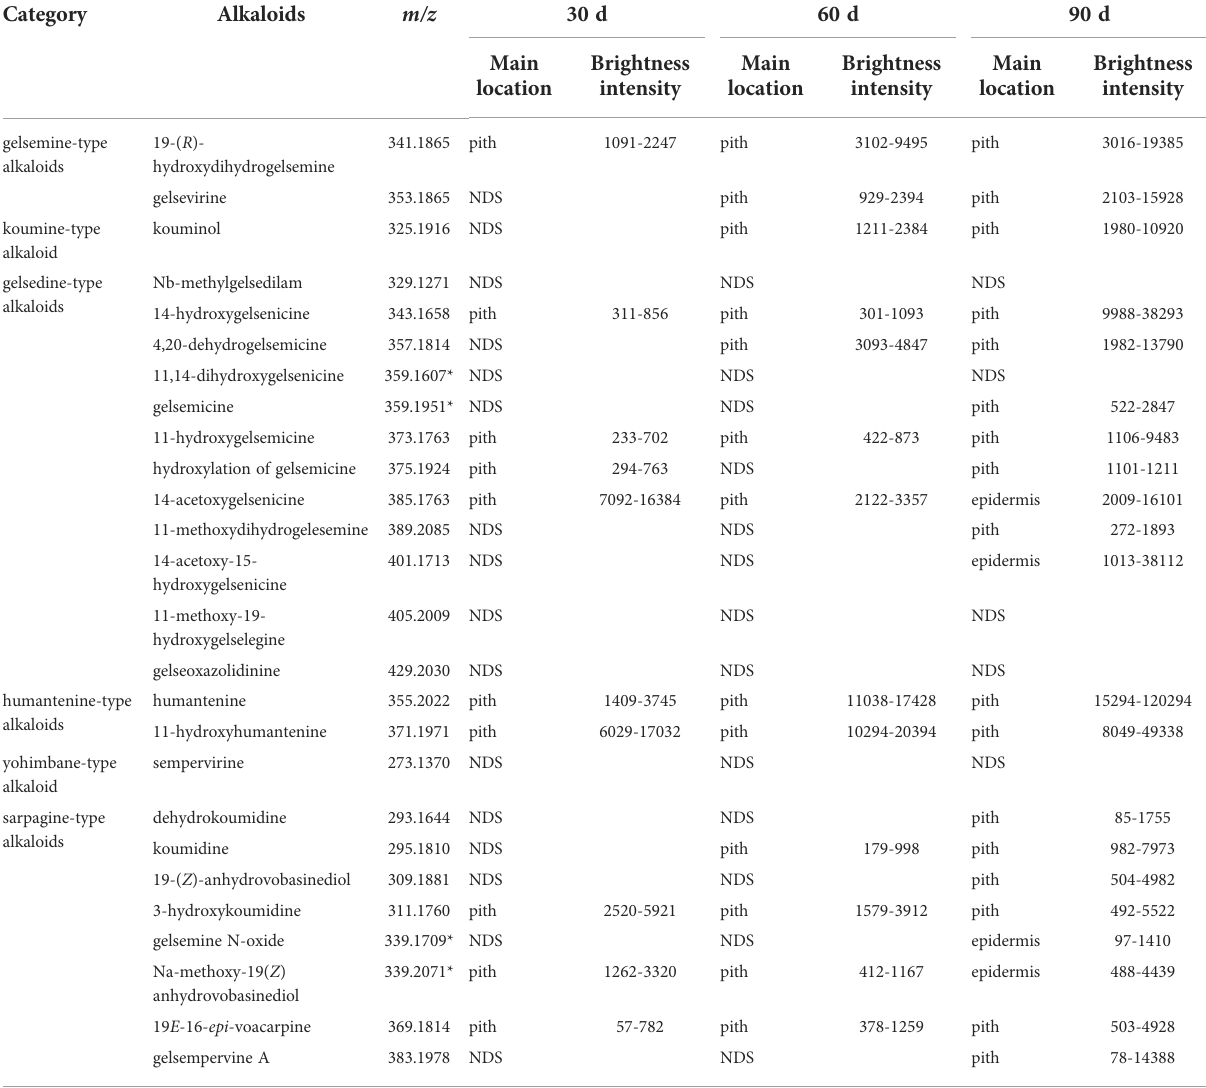
TABLE 3 Distribution of alkaloids in seedling